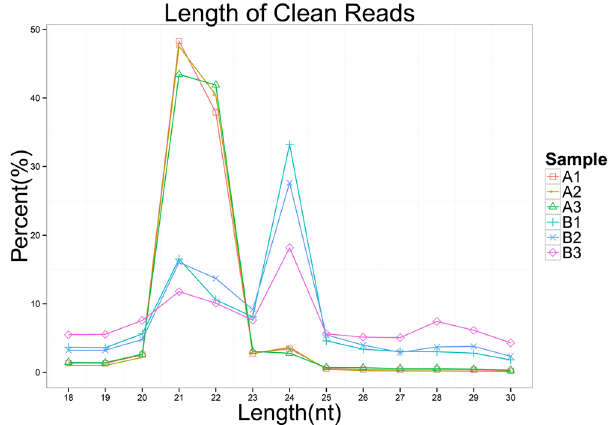
Figure 1. Length distribution of tags in the small RNA libraries. The relative abundance of small RNA with length ranging from 18–30 nt are shown in the graph.